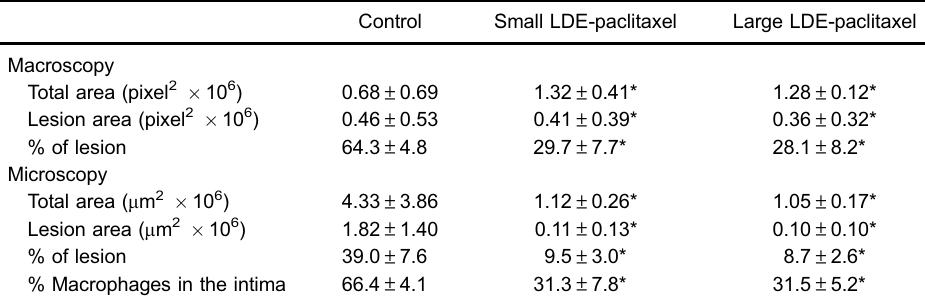
Table 3. Macroscopic and microscopic morphometry of rabbit aortas treated with saline solution (n=9), small lipid nanoparticles (LDE)-paclitaxel (n=10) or large LDE-paclitaxel